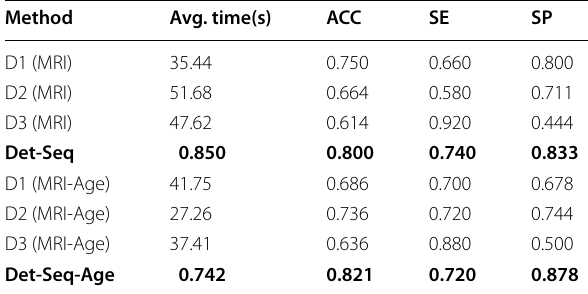
Table 4 Comparison between WFF and three doctors for benign and malignant tumor